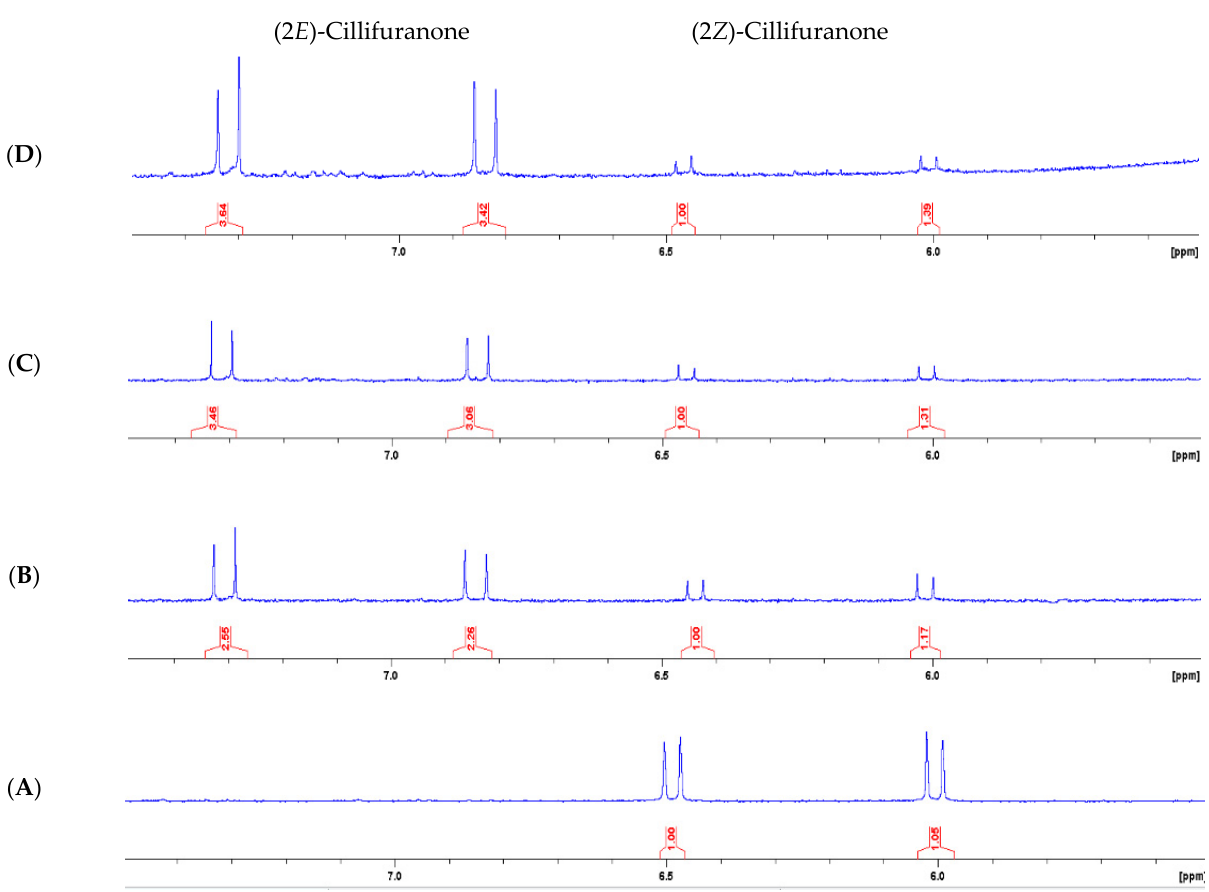
Figure 4. Time-controlled experiment of (2 Z )-cillifuranone ( 1 ) isomerisation. ( A ): time zero, ( B ): three months after time zero, ( C ): six months after time zero, ( D ): nine months after time zero.